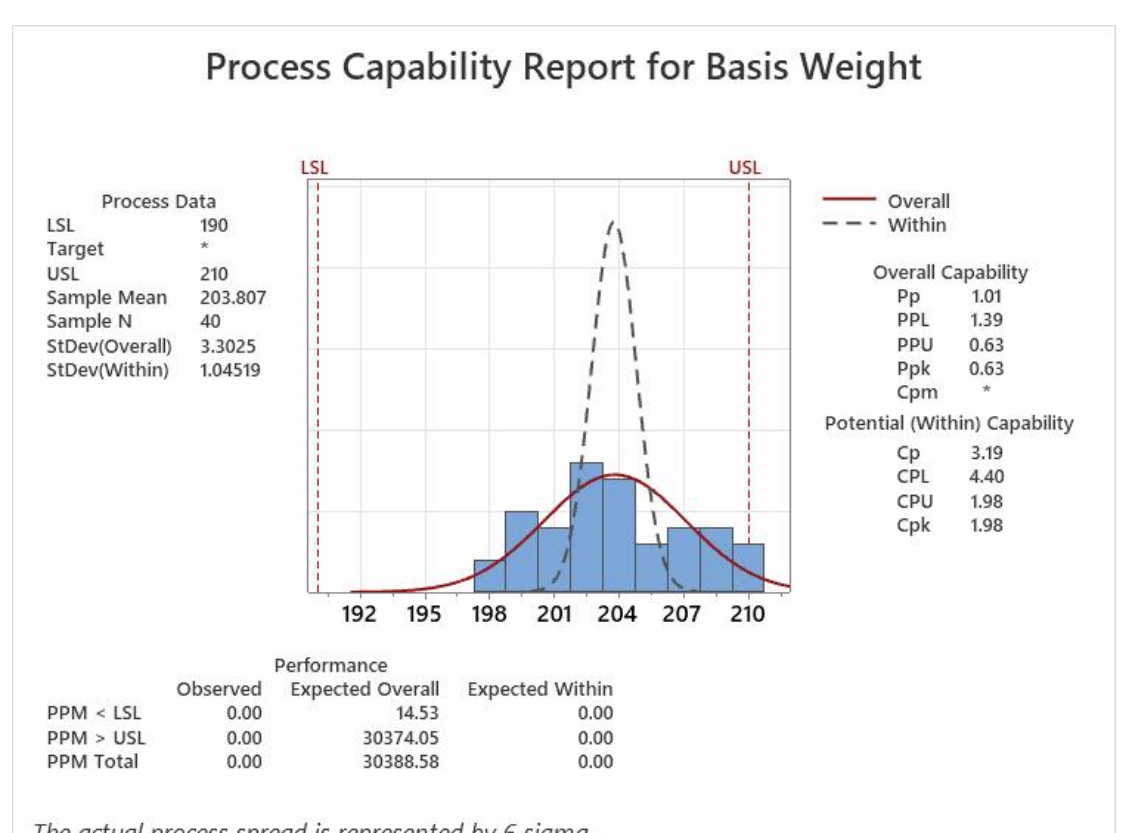
Figure 14. The membership function of 𝜎 -level.